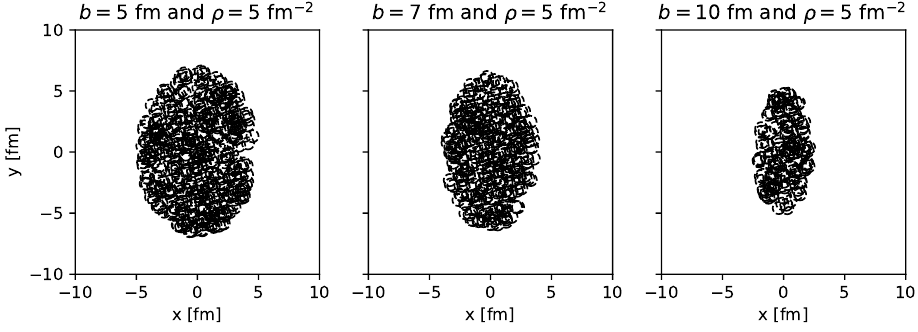
Figure 7 . Examples of a sampled ellipse configuration in the Pb-Pb toy model, at three different impact parameters, with ρ = 5 fm − 2